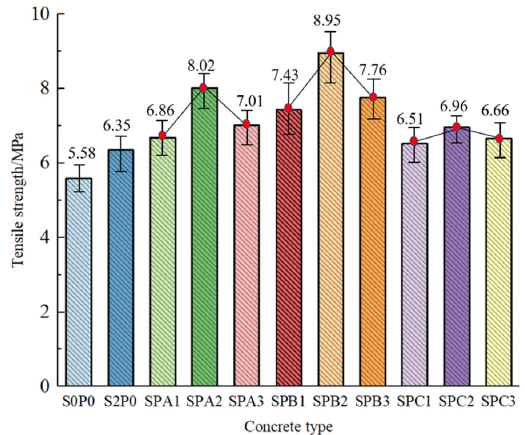
Figure 5. Splitting tensile strength of concrete specimens in each group.